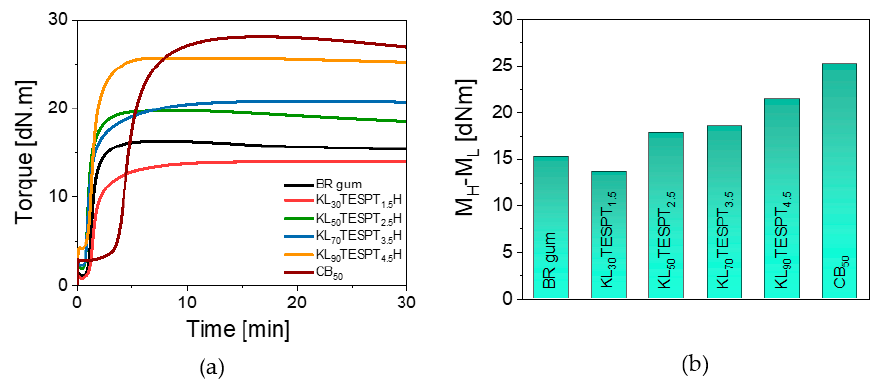
Figure 2. ( a ) Torque development during the vulcanization in a moving die rheometer and ( b ) extent of curing ( M H − M L ) (represented as a bar diagram) of all the BR–lignin and BR–carbon black composites.